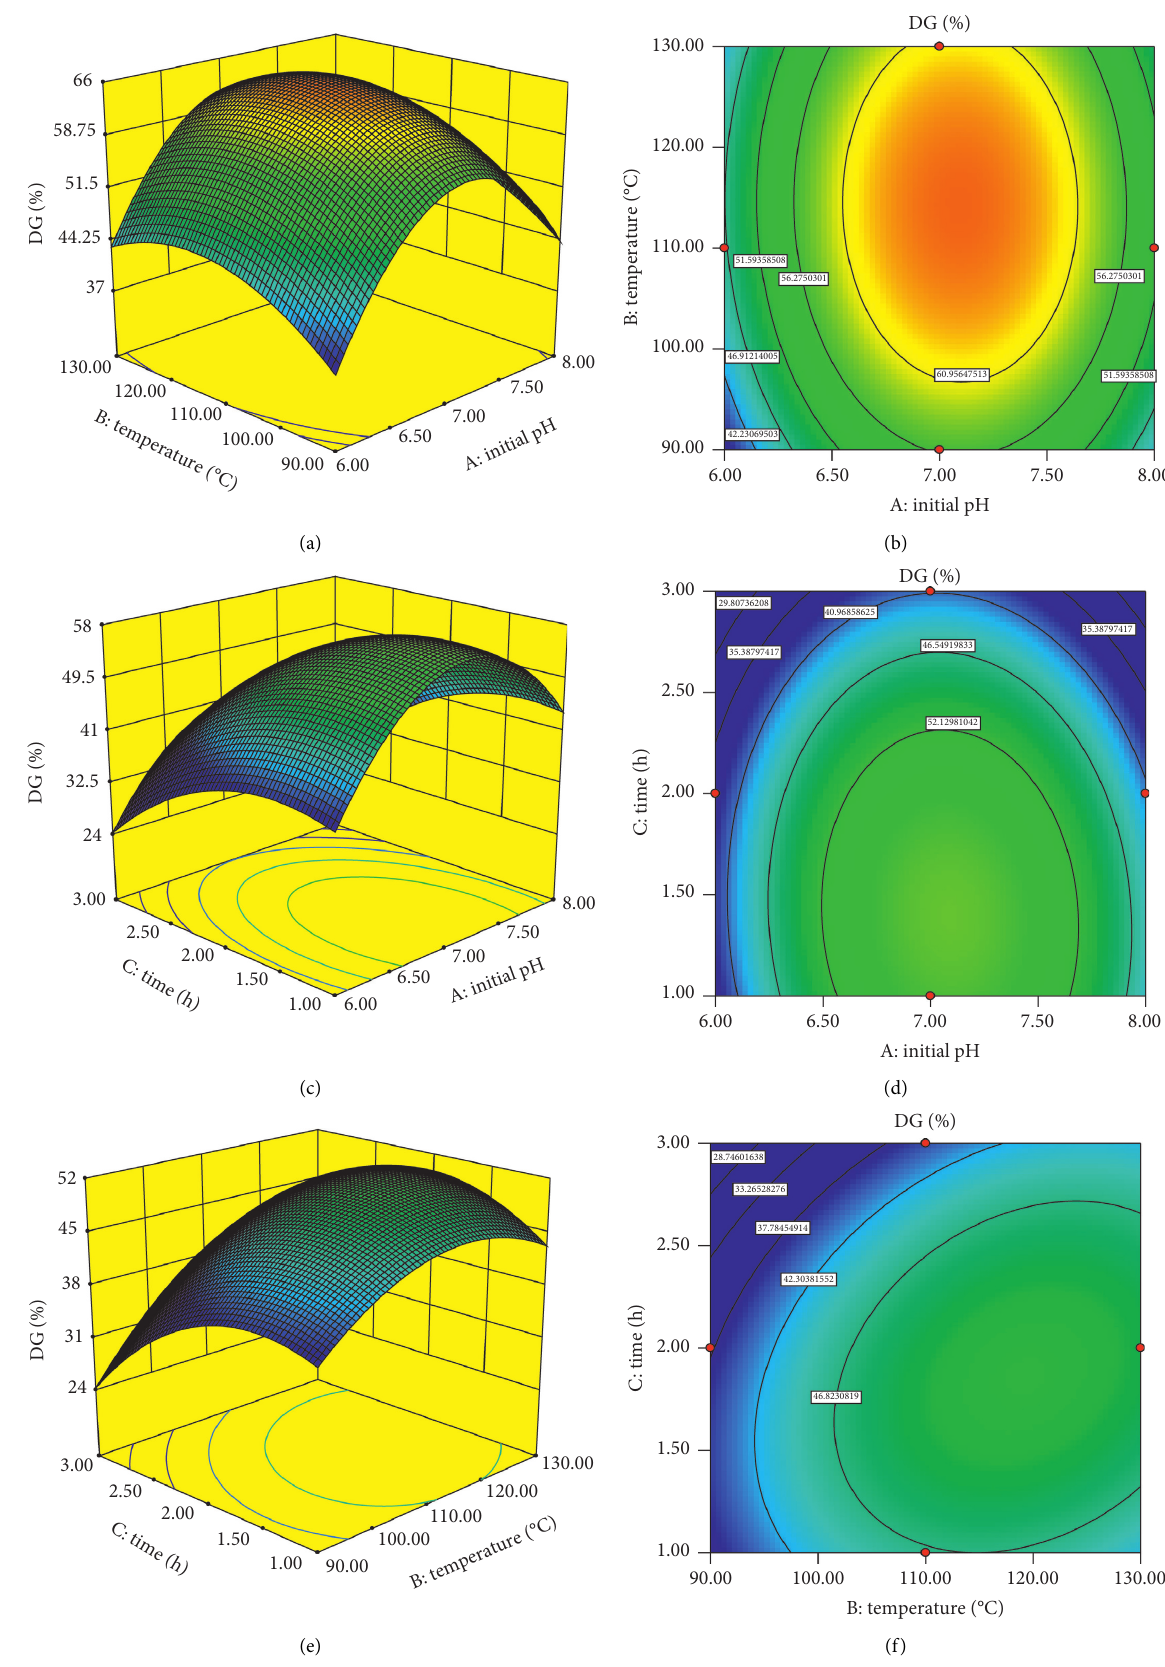
Figure 3: Response surface plots (a, c, and e) and contour plots (b, d, and f) for the interactive effects of initial pH ( x time ( x 3 ) on the DG of the Maillard